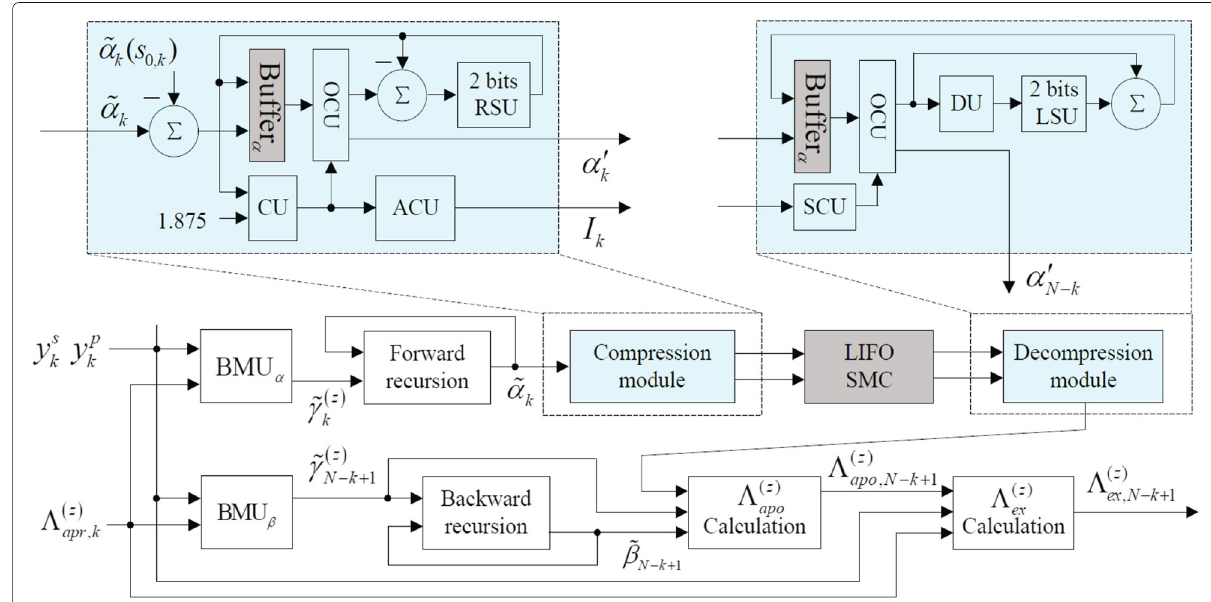
Fig. 2 State metrics compressed turbo decoding architecture